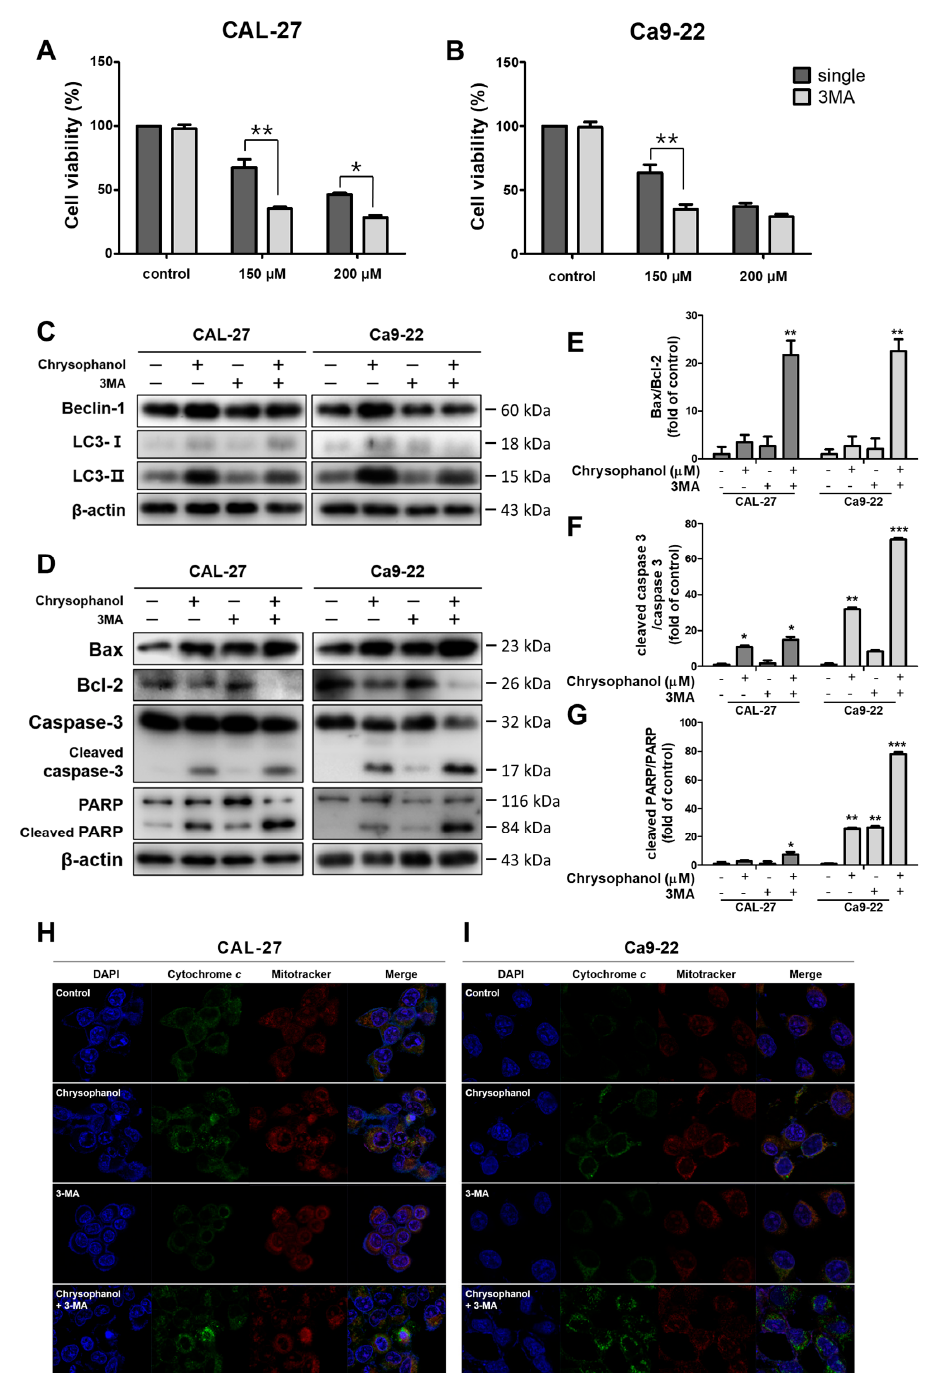
Figure 5. It was found that 3-MA inhibited autophagy and cooperated with apoptosis, which was occasioned by chrysophanol in CAL-27 and Ca9-22 cells. ( A , B ) Cell viability was executed by an MTT assay after chrysophanol treatments with or without 3-MAfor 24 h. ( C , D ) The protein expression levels of autophagy-associated proteins (ATG5, beclin-1, and LC3B) and apoptosis-associated proteins (Bax, Bcl-2, Caspase -3, and PARP) were detected by using a Western blot analysis. β -actin was used to present a loading control. ( E – G ) Bax/Bcl-2, cleaved caspase -3/caspase -3, and cleaved PARP/PARP ratios were calculated by using the Western blot band density. ( H , I ) Chrysophanol (0, 150 μ M) was treated with both cells in the presence or absence 3-MA, and then the revelation of cytochrome c was visualized by immunofluorescence analyses. The results are exhibited as mean ± SD (* p < 0.05, ** p < 0.01, and *** p <